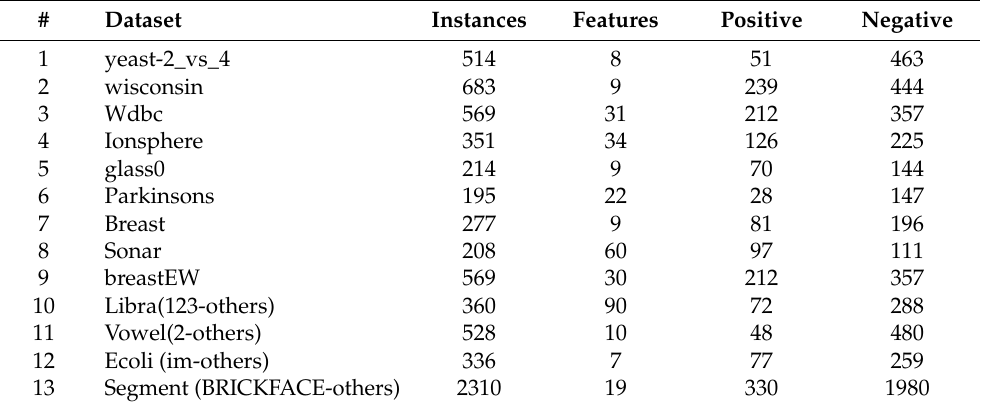
Table 2. Characteristics of the real-world datasets.